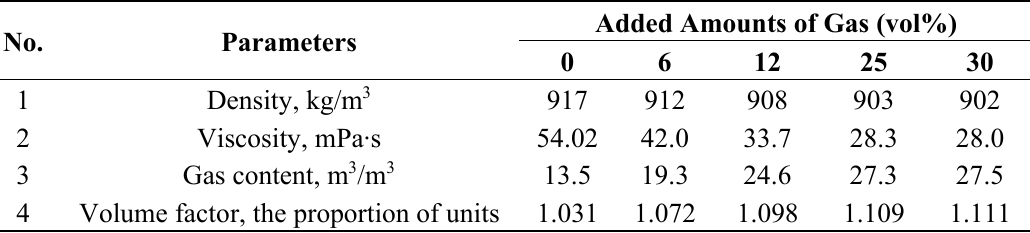
Table 7. Parameters of water-gas mixture depending on the added amounts of gas.